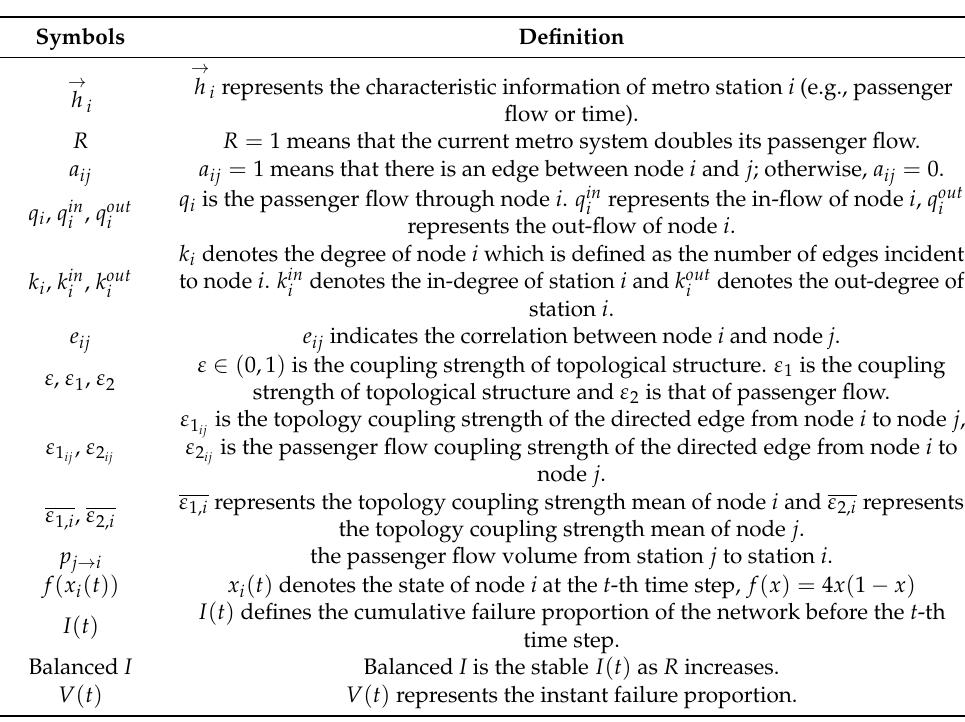
Table 2. Symbols and